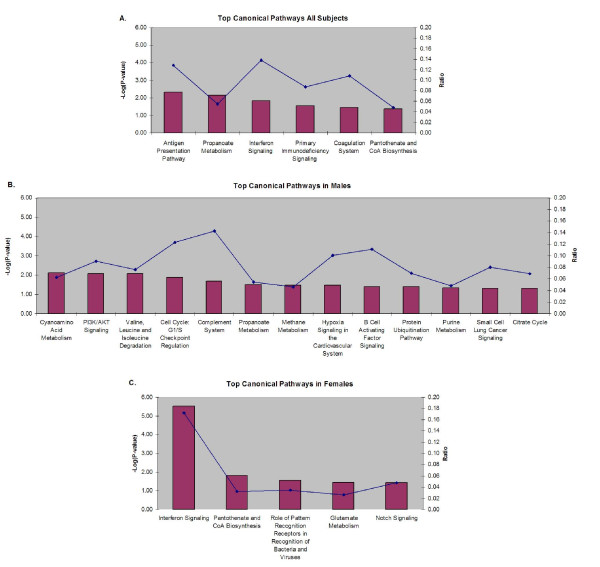
Canonical Pathway Analysis of Serum IgE in CD4+ Lymphocytes. Figures A-C represent the results of Canonical Pathway Analyses using Ingenuity Pathway Analysis ([IPA], Ingenuity Systems®, http://www.ingenuity.com) software in all subjects, males, and females respectively. The significance of the association between the our data set and identified pathways from the Ingenuity Pathway Analysis library of canonical pathways was measured as a ratio of the number of genes from our dataset that map to the pathway divided by the total number of molecules that exist within the canonical pathway (presented as a line plot). Fischer's exact tests were used to calculate p-values (presented as -log10 p values in a bar graph). In all subjects 763 transcripts demonstrated nominally significant (p < 0.05) correlation with total serum IgE. Of these 763 transcripts, 652 (85%) mapped to a unique HUGO gene id and were used for IPA canonical pathway analysis. Six pathways were nominally significant using a Fisher's exact test and are listed in Figure 2A. Among males, 900 transcripts were correlated with total serum IgE, 873 (97%) mapped to a unique HUGO gene id, and thirteen pathways were significant (Figure 2B). Among females, 158 transcripts were correlated with total serum IgE, 154 (97%) mapped to unique HUGO gene ids, and six pathways were significant (Figure 2C).